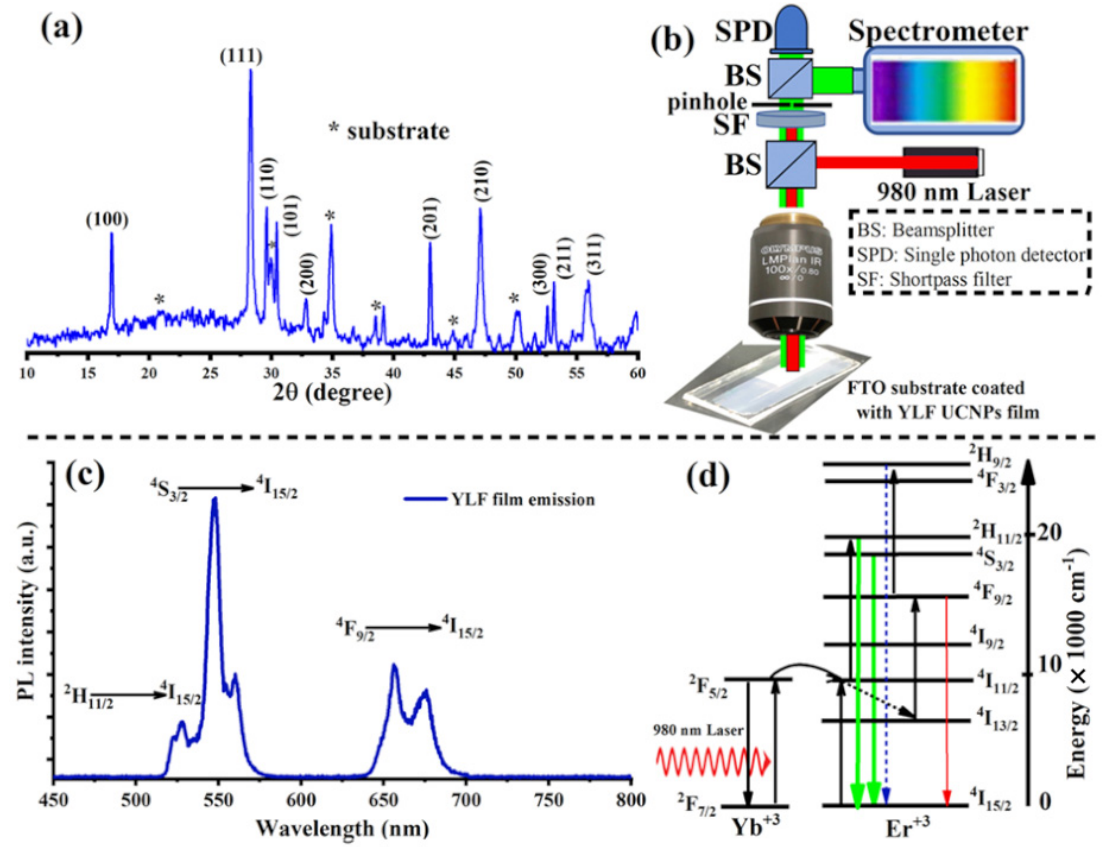
Figure 2. ( a ) XRD patterns of lithium-based UC thin films, LiYF4: Yb, Er, electrodeposited at 70 ◦ C and annealed at 300 ◦ C in air for 6 h. ( b ) An illustration of a home-made confocal microscope equipped with a 980 nm laser for photoluminescence (PL) measurement of electrodeposited UC thin films. ( c ) A strong UC emission spectrum measured directly from the electrodeposited UC thin films after air annealing. ( d ) The upconversion mechanisms of Er 3 + and Yb 3 + ions in the electrodeposited UC films under a 980 nm